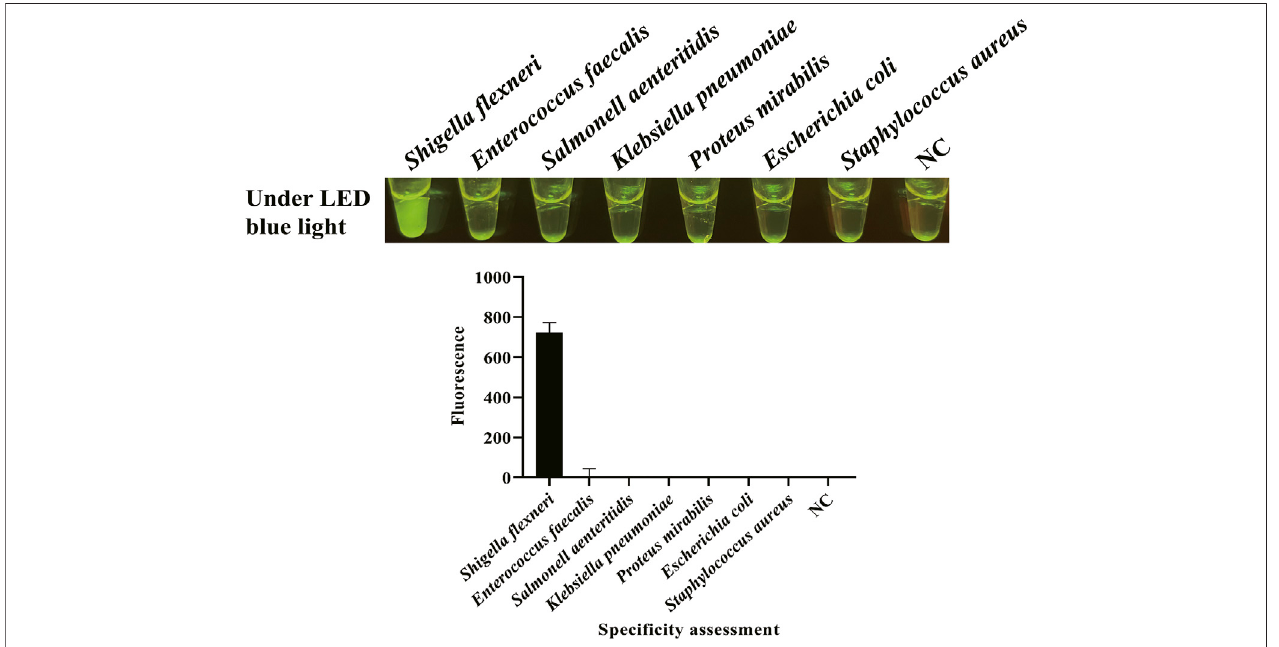
FIGURE4| Speci fi cityevaluationofCRISPR/Cas12a-E-LAMP.gDNAof S. fl exneri andnon- S. fl exneri ( E.faecalis , S.enteritidis , K.pneumoniae , P.mirabilis , E.coli , and S. aureus ) were used as the template for the speci fi city evaluation of CRISPR/Cas12a-E-LAMP by endpoint fl uorescence photography and endpoint fl uorescence